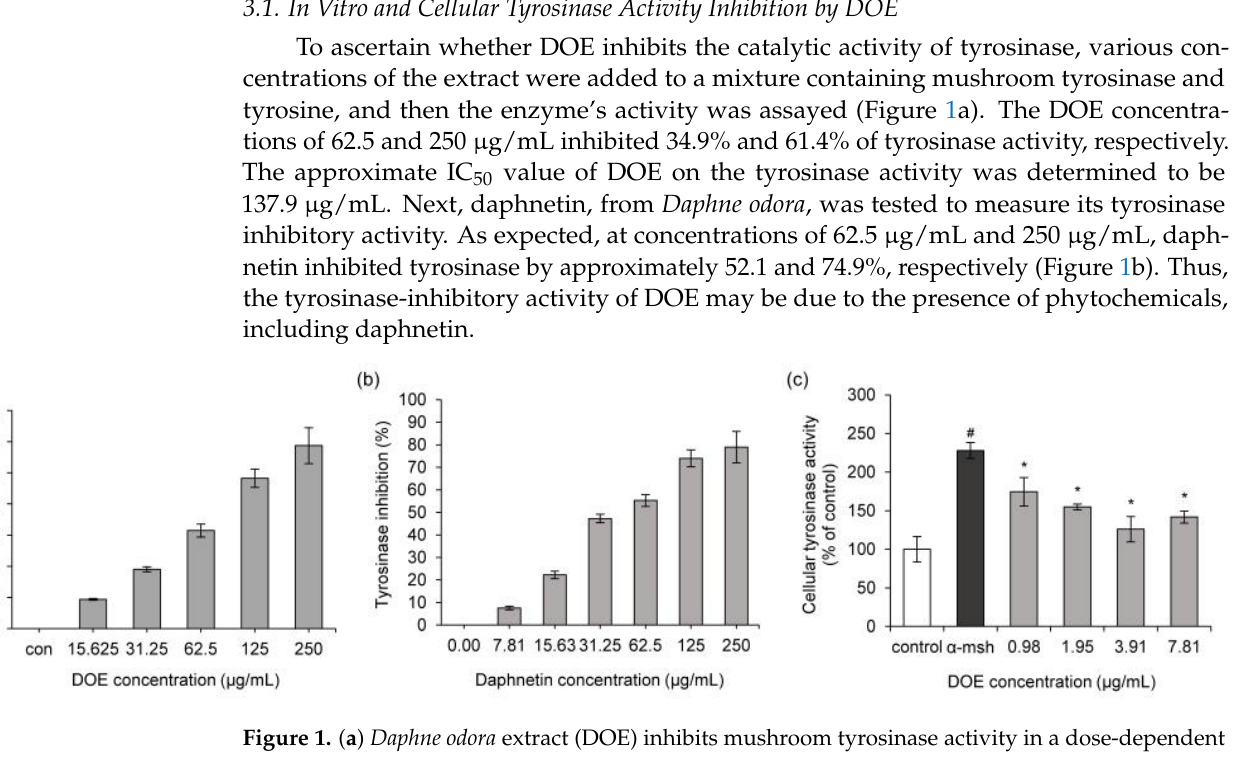
Figure 1. ( a ) Daphne odora extract (DOE) inhibits mushroom tyrosinase activity in a dose-dependent manner. ( b ) Daphnetin inhibits mushroom tyrosinase activity in a dose-dependent manner. ( c ) DOE inhibits cellular tyrosinase activity in α -MSH-treated B16F10 cells. # p < 0.05 vs. control. * p < 0.05 vs. α -MSH-treated